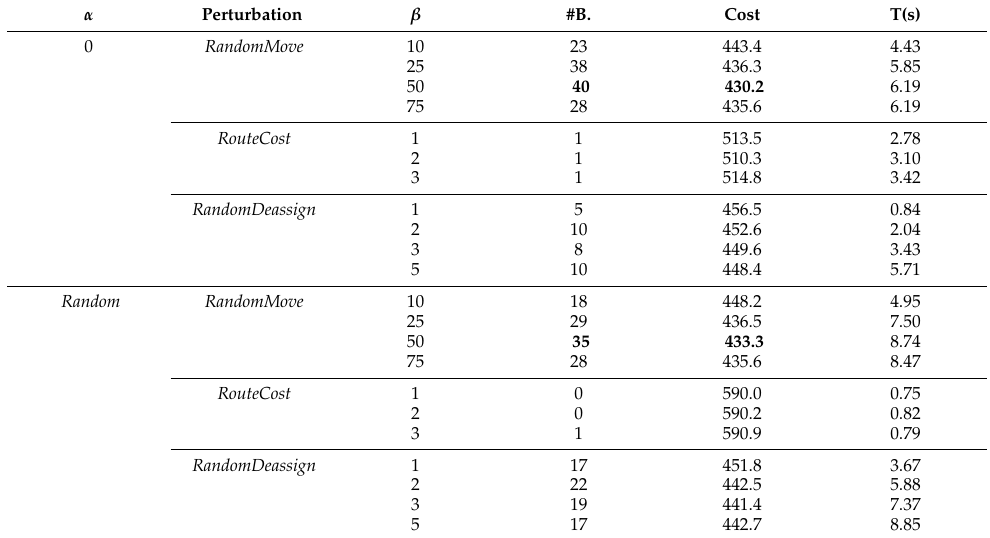
Table 3. Performance comparison among the proposed perturbation